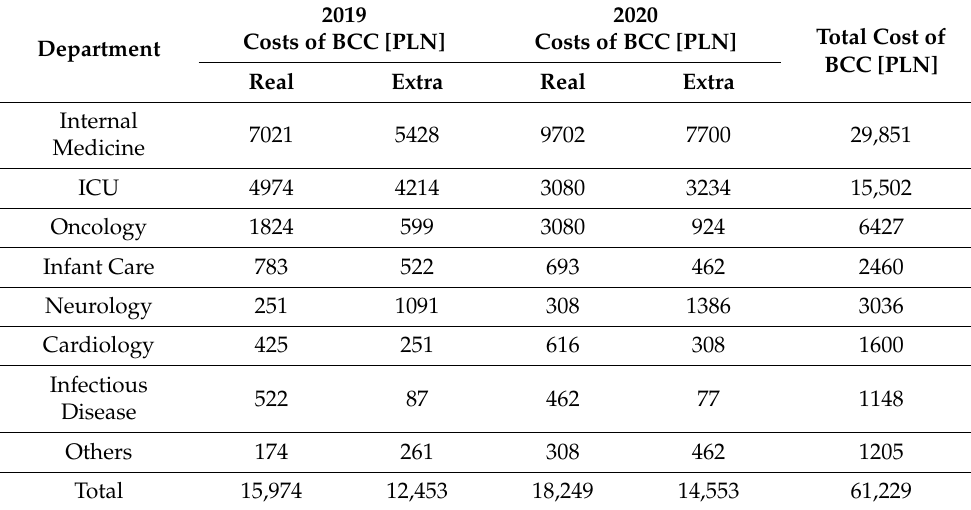
Table 3. Hospital laboratory cost profile due to occurrence of blood culture contamination in 2019 and